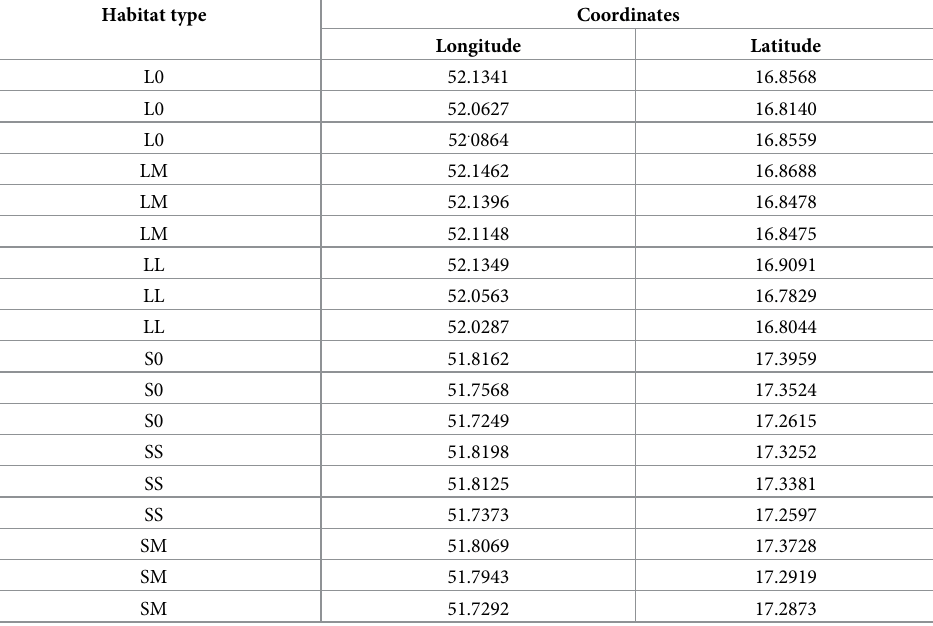
Table 2. Geographic coordinates (decimal degrees) of the study